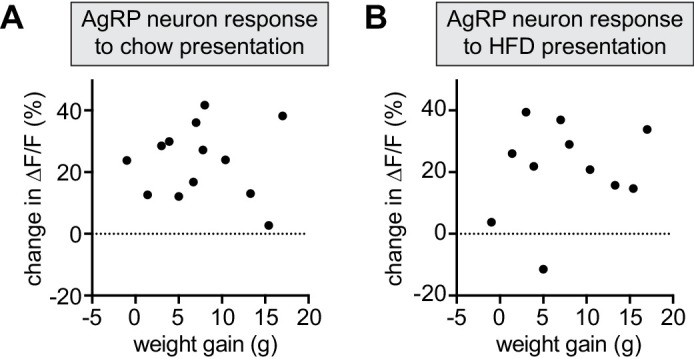
Magnitude of DIO-induced changes in AgRP neuron dynamics are not correlated with amount of weight gain.(A and B) Change in ∆F/F (response after 6 weeks HFD exposure minus response at baseline) in fasted DIO animals presented with chow (A) or HFD (B) plotted against the weight gain of individual animals. (A) R2 = 0.001, p=0.90 (n = 13 mice) (B) R2 = 0.028, p=0.62 (n = 11 mice).